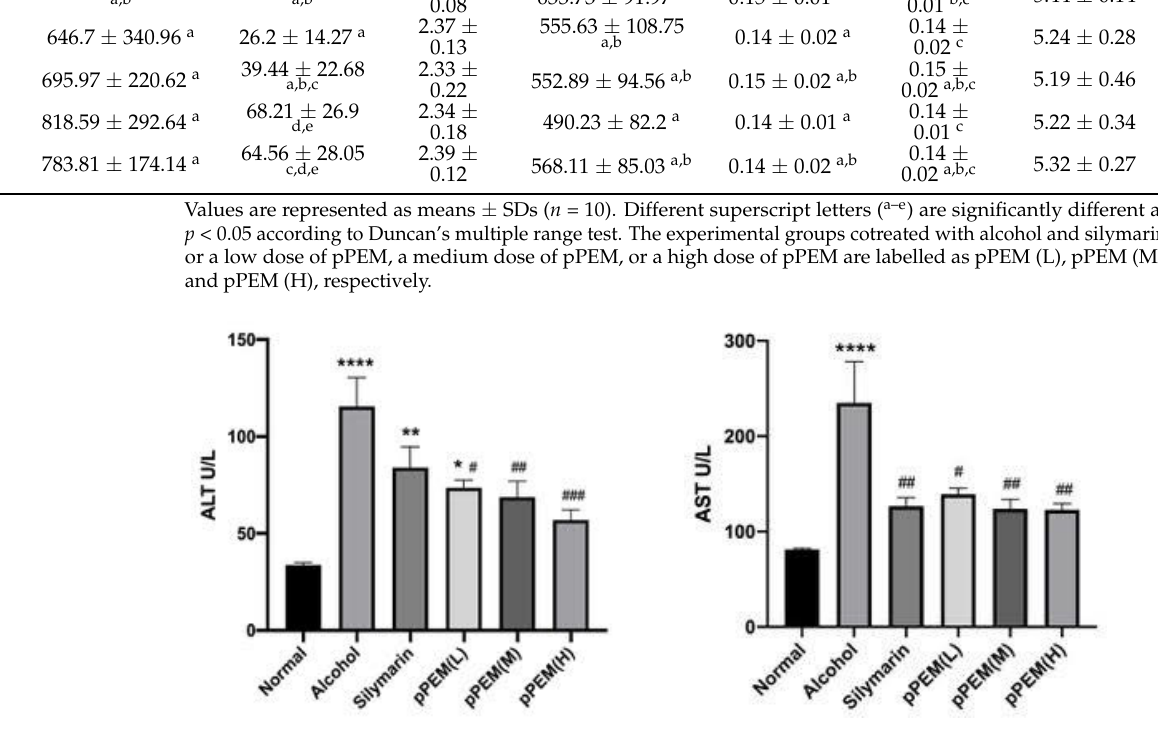
Figure 2. Effects of pPEM and silymarin on serum ALT and AST levels in alcohol-treated rats. The values are represented as means ± SDs ( n = 10). The symbols in the figures show statistically signif- icant differences among the groups as follows: * p < 0.05, ** p < 0.01, **** p < 0.001 vs. Normal Group;